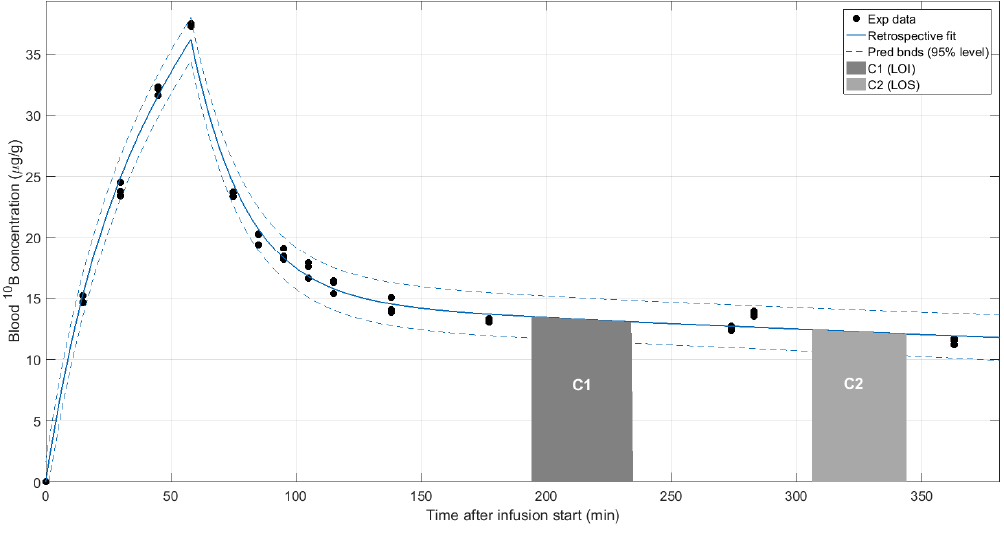
Figure 1. Blood 10 B concentration–time profile after start of infusion. C1 and C2 correspond to the two portal irradiations.